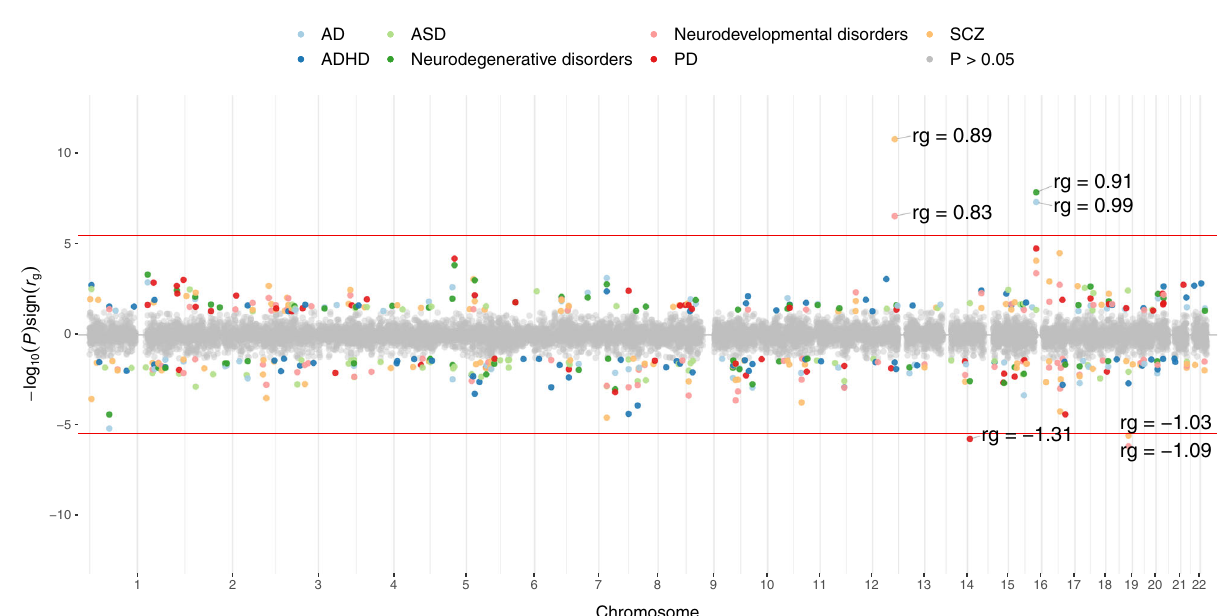
Fig. 4 Local genetic correlations between cerebellar volume and disease. Local genetic correlations ( r g ) between cerebellar volume and neurodevelopmental and neurodegenerative disorders. The red line indicates the signi fi cance threshold, Bonferroni corrected for the number of loci tested in all seven traits. As during global r g , we meta-analysed the ADHD, ASD and SCZ summary statistics to represent the genetic signal of the overarching neurodevelopmental disorder dimension and similarly meta-analysed PD and AD summary statistics to capture the genetic signal of the neurodegenerative disorder dimension (see “ Methods ” ). Table 1 Local genetic correlations between cerebellar volume and disease. Trait